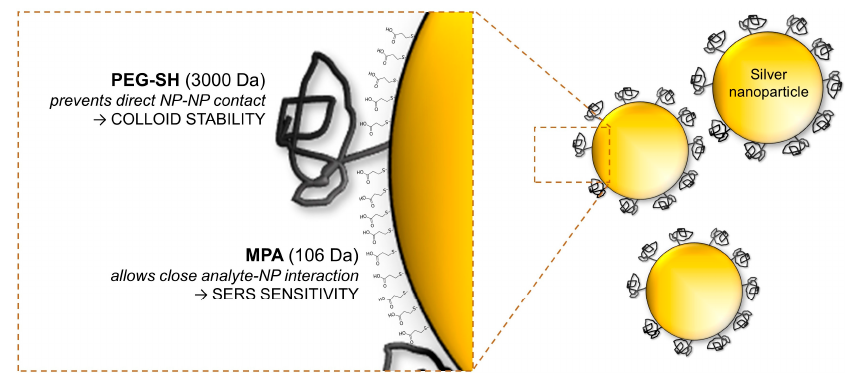
Figure 1. The bi-ligand design of the nanoparticles (NPs) surface modification for sensitive surface- enhanced Raman spectrometry (SERS) measurements using a combination of the